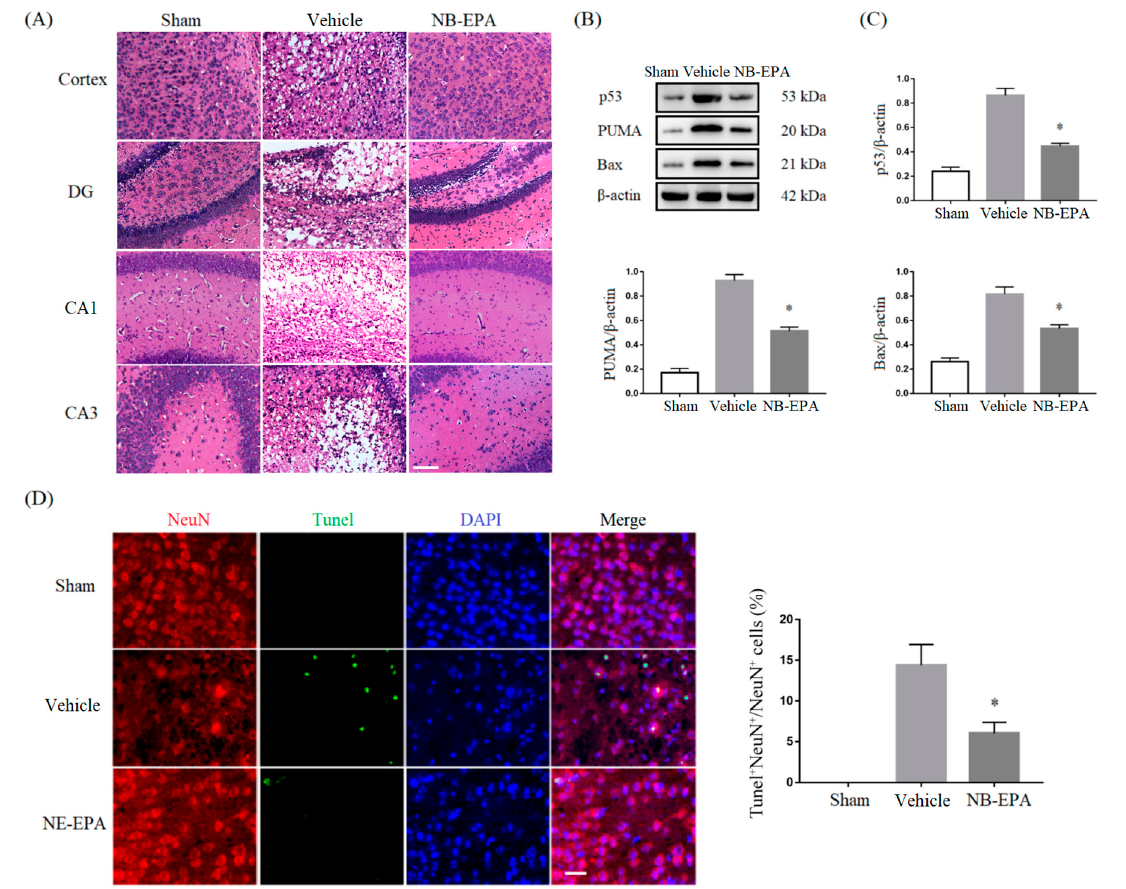
Figure 3. NB-EPA inhibits neuronal death in neonatal mice after HI brain injury. ( A ) Representative photographs of HE staining in the cortex, hippocampus DG, CA1 and CA3 regions from every group of mice at 7 days post-HI (Scale bar, 75 μ m). ( B ) Representative Western blot images of p53, PUMA, and Bax from every group of mice at 7 days after HI. ( C ) Densitometric analysis of data is shown in ( B ). ( D ) Representative images of NeuN (red) and TUNEL (green) from every group of mice at 7 days post-HI (left, Scale bar, 25 μ m) in cerebral cortex; Quantification of NeuN and TUNEL dual-labeled cells at 7 days post-HI (Right). Data are mean ± SEM ( n = 8 per group). * p < 0.05 compared to vehicle.